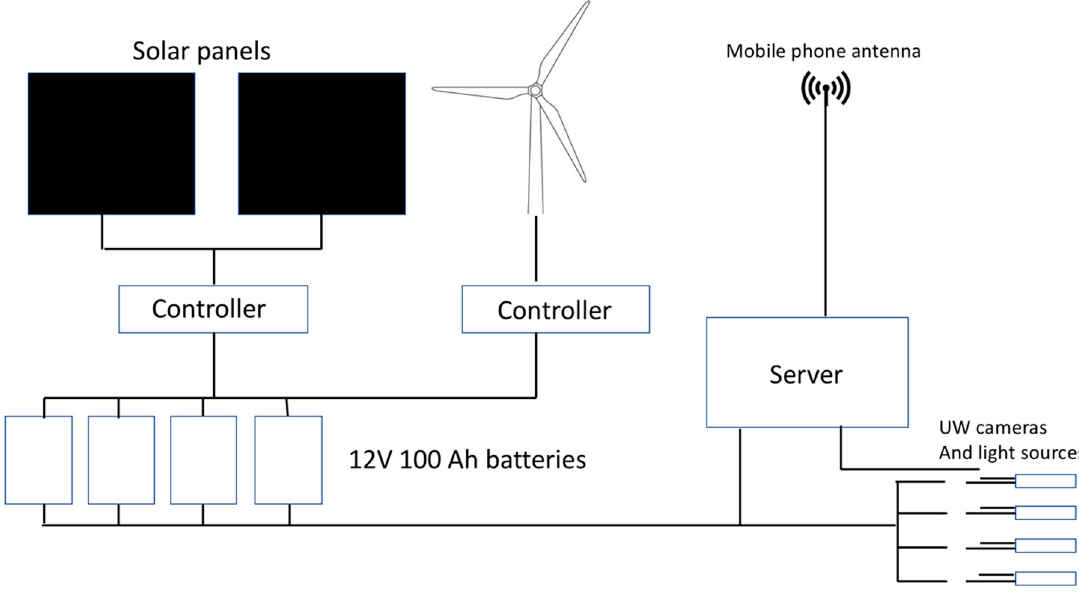
Figure 4. Electronic diagram of the system.